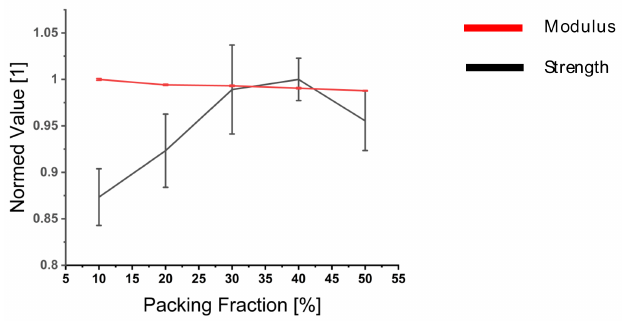
Figure 15. Parameter study of yarn packing fraction influence on composite properties.